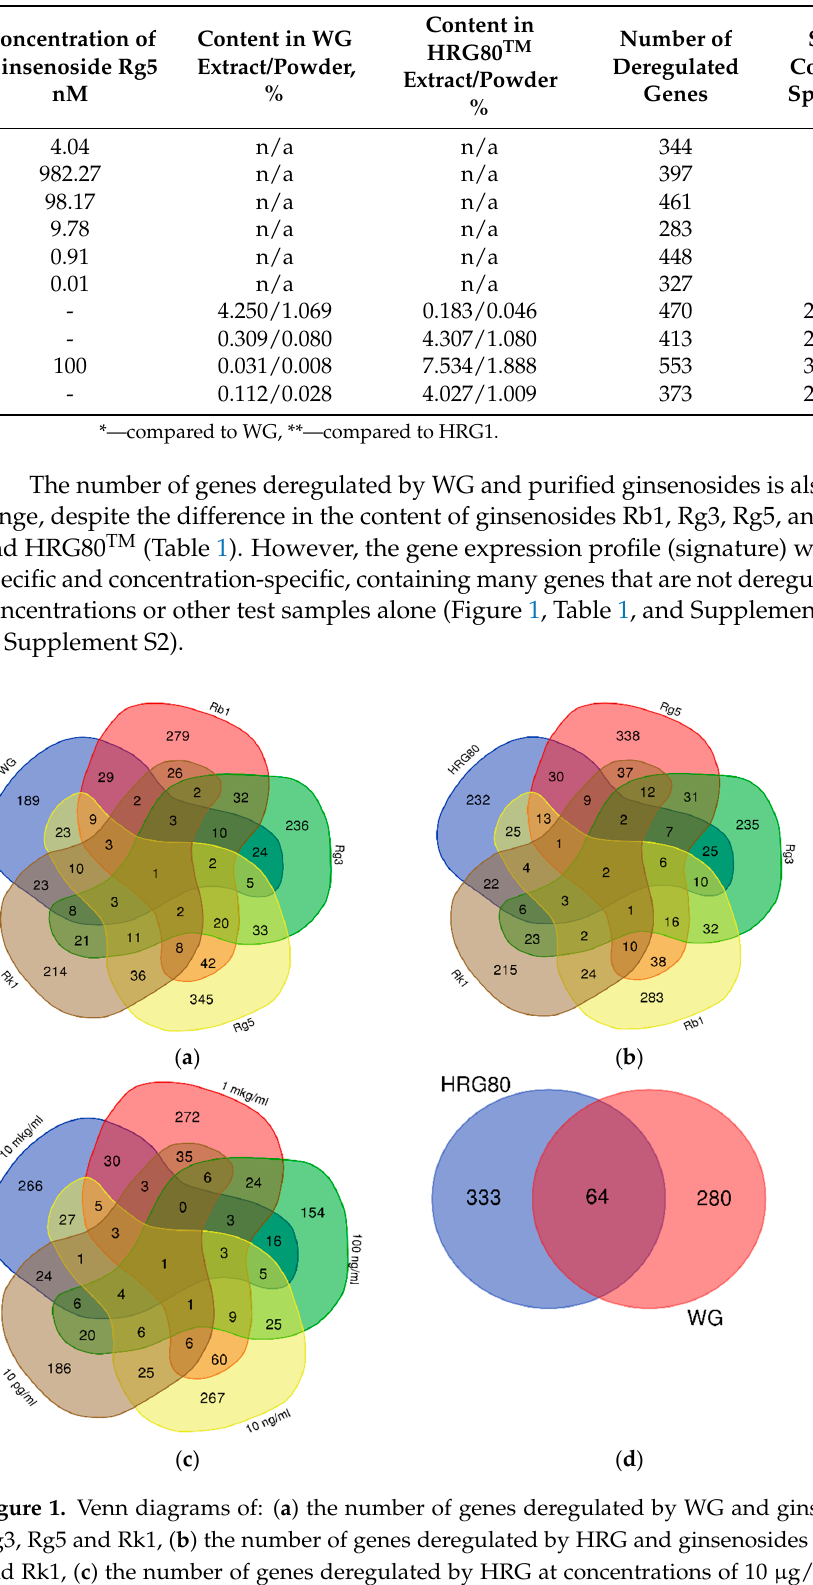
Table 1. The number of genes deregulated (>20 fold compared to controls) by ginsenosides Rb1, Rg3, Rg5 and Rk1, WG and